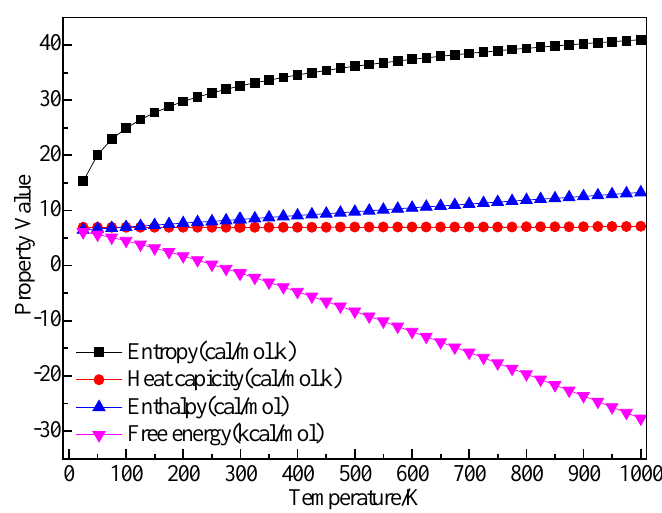
Figure 15. The relationship between the thermodynamic properties of H 2 and temperature.